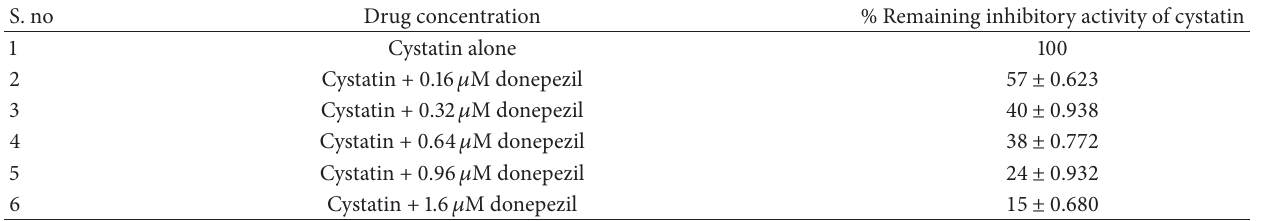
Table 1: Inhibitory activity of cystatin in the presence of donepezil.